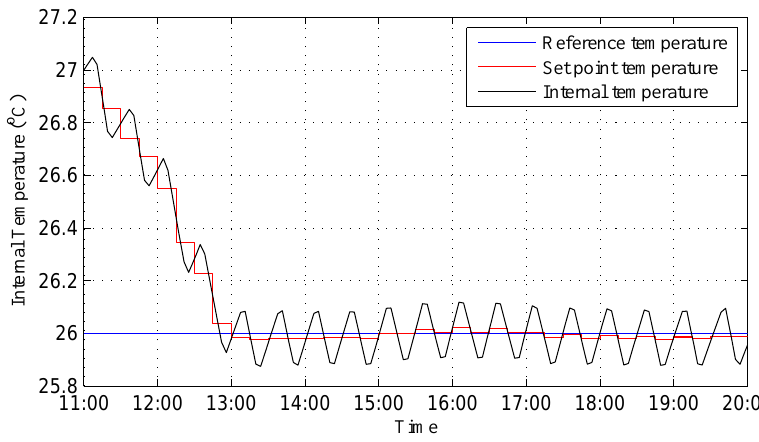
Figure 7. Set-point temperature and Internal temperature of the